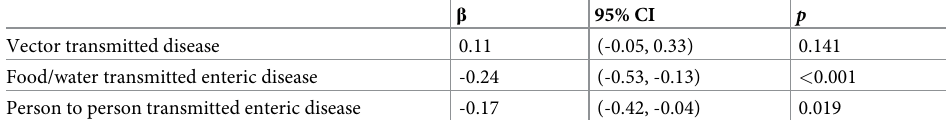
Table 3. Linear latent model results of the association between the school WASH intervention and disease response variables. β 95% CI p Vector transmitted disease 0.11 (-0.05, 0.33) 0.141 Food/water transmitted enteric disease -0.24 (-0.53, -0.13) < 0.001 Person to person transmitted enteric disease -0.17 (-0.42, -0.04) 0.019 β represents change in latent variable mean Model controls for pupil age, grade, and household access to WASH and includes a random intercept for school p < 0.05 is considered statistically significant